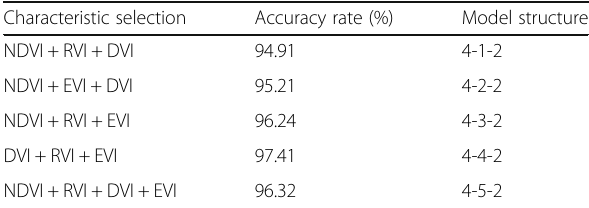
Table 5 Different number of hidden layer Characteristic selection Accuracy rate (%) Model